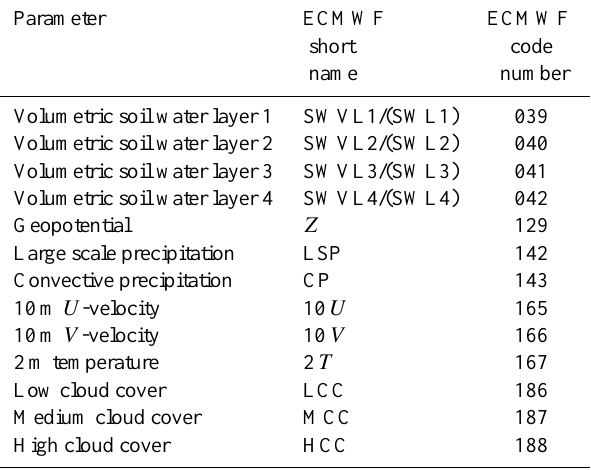
Table 2. Summary of meteorological input data from ECMWF, including short names and code